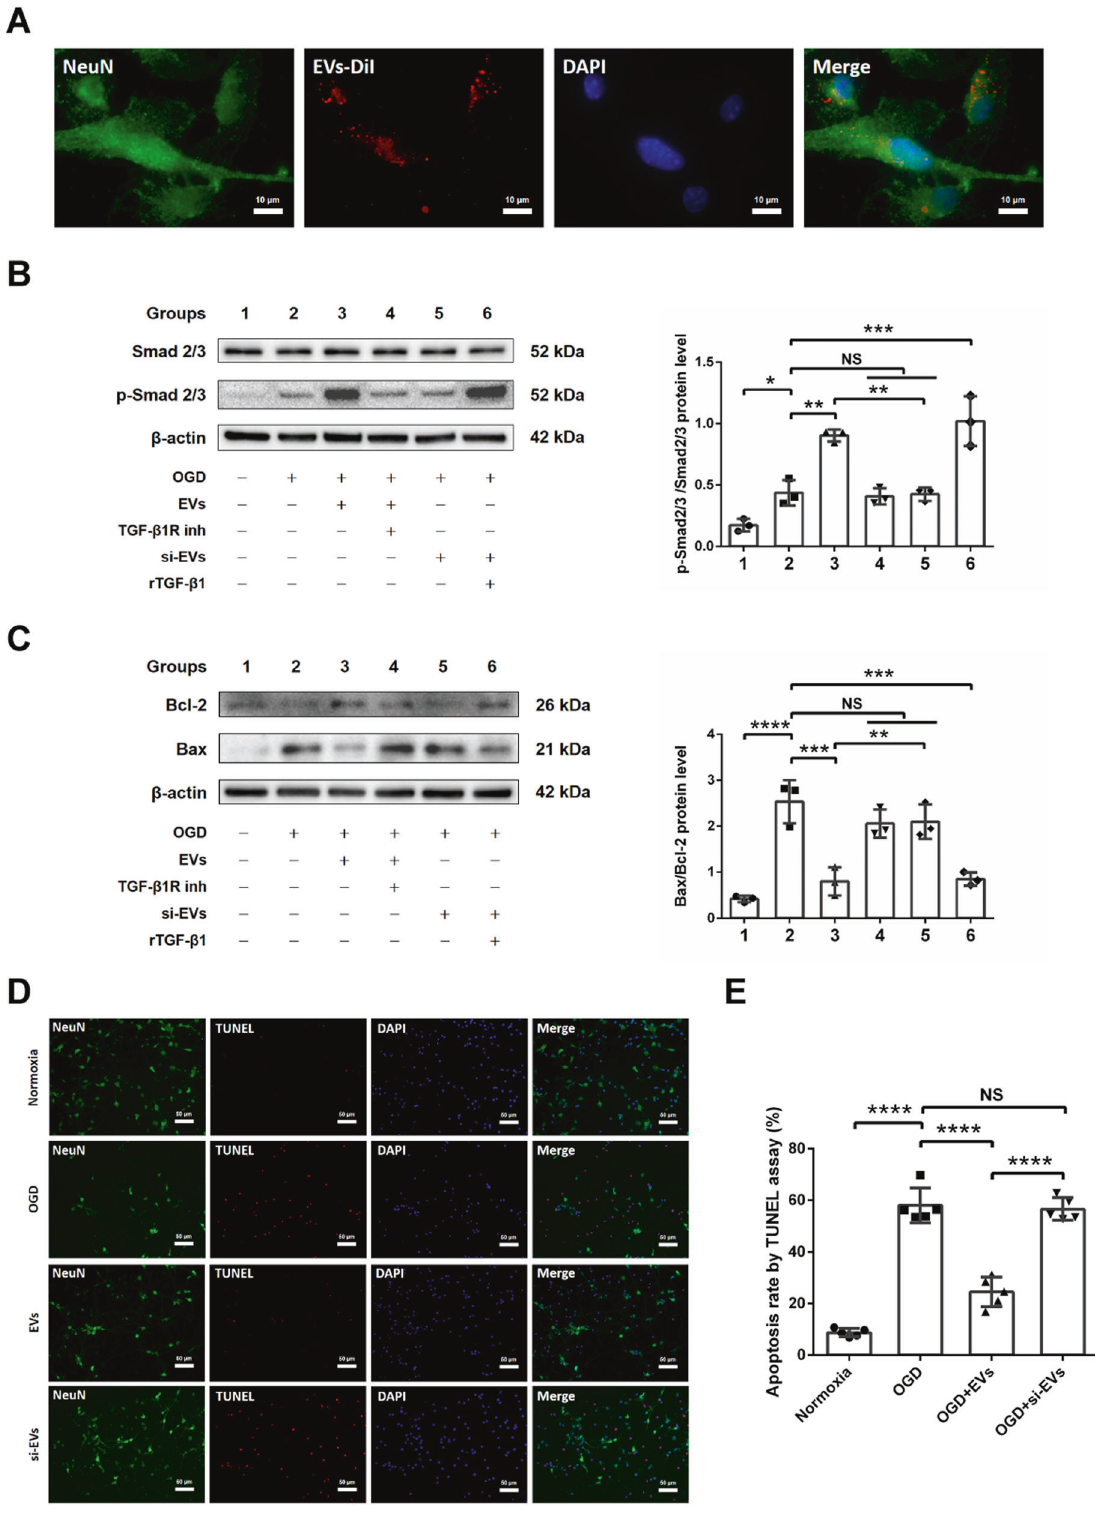
TGF- β 1 siRNA transfection of microglia Primary microglia were stably transfected with FlexiTube small interfering RNA (siRNA) for mouse TGF- β 1 (NM_011577) or negative control siRNA using HiPerFect Transfection Reagent (Qiagen, Hilden, Germany). The siRNA transfection was performed in serum-free medium, following the manufacturer ’ s instruction. The most ef fi cient target sequence for RNA